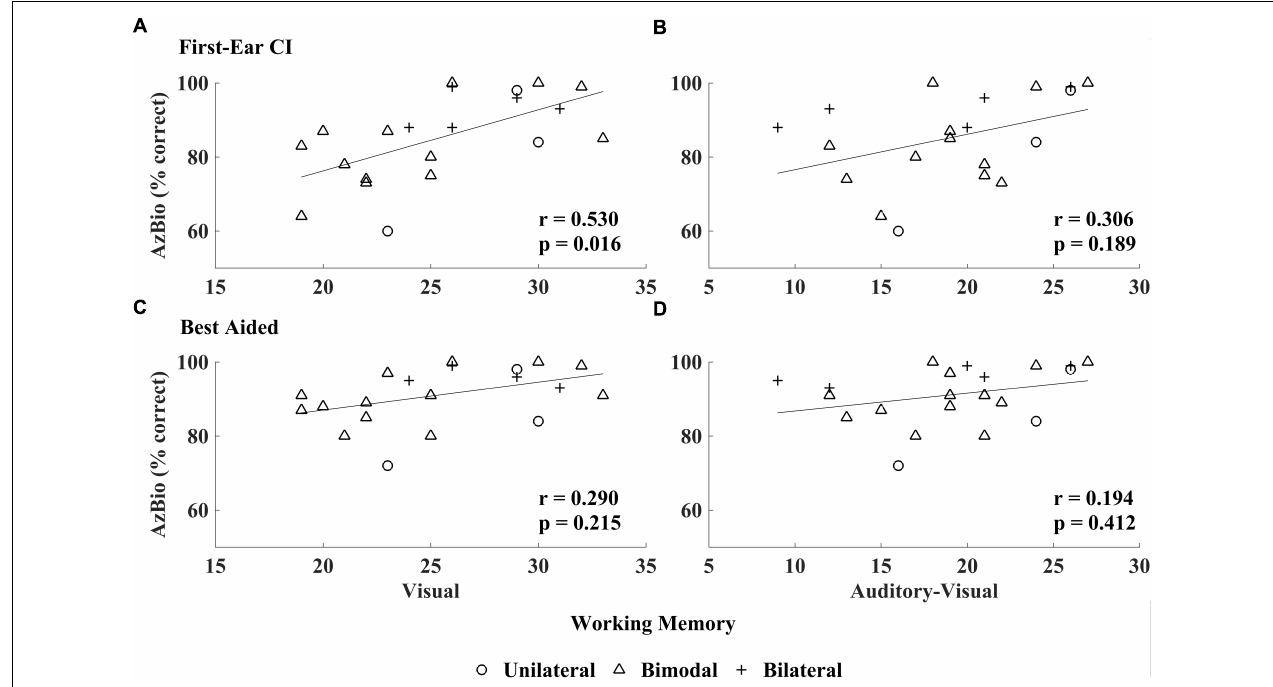
FIGURE 2 | Relationship between CI speech perception in quiet and working memory scores: visual working memory (VWM) and auditory-visual working memory (AVWM). AzBio scores obtained in the first-ear CI test condition related to VWM (A) unlike AVWM (B) ; best-aided speech perception (i.e., unilateral CI, bimodal CI and HA, bilateral CI) related to neither VWM (C) nor AVWM (D) .